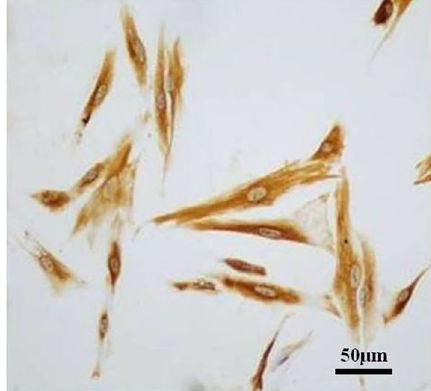
Figure 1. Immunocytochemical identi fi cation of endometrial stromal cells (scale bar 50 m m).